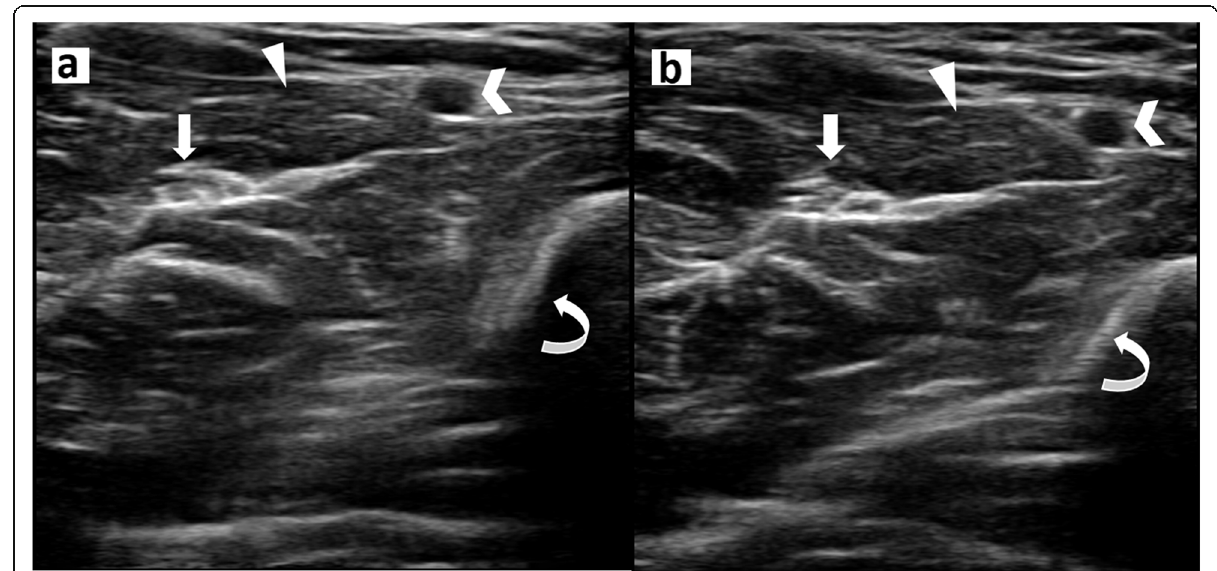
Fig. 2 Transverse ultrasound images of the left mid forearm obtained through conventional ( a ) and robotic ( b ) techniques which demonstrate median nerve (arrow), flexor digitorum superficialis muscle (arrow head), radial artery (chevron), and radius (curved